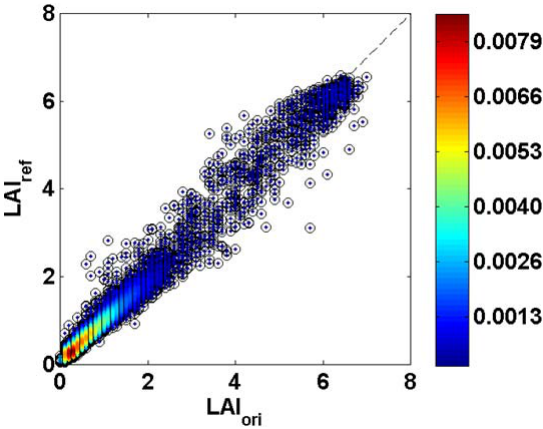
Fig. 3. Comparison between the original LAI values (LAI ori ) and the median of the reconstructed values (LAI ref ) based on the 8 methods considered over the 25 selected sites (Table 2, Fig. 2) ( N = 7561; R 2 = 0.90; RMSE = 0.231; Bias =− 0 . 008). The col- ors of this density plot correspond to the frequency of data in each of the 0.1 × 0.1 cells LAI values.